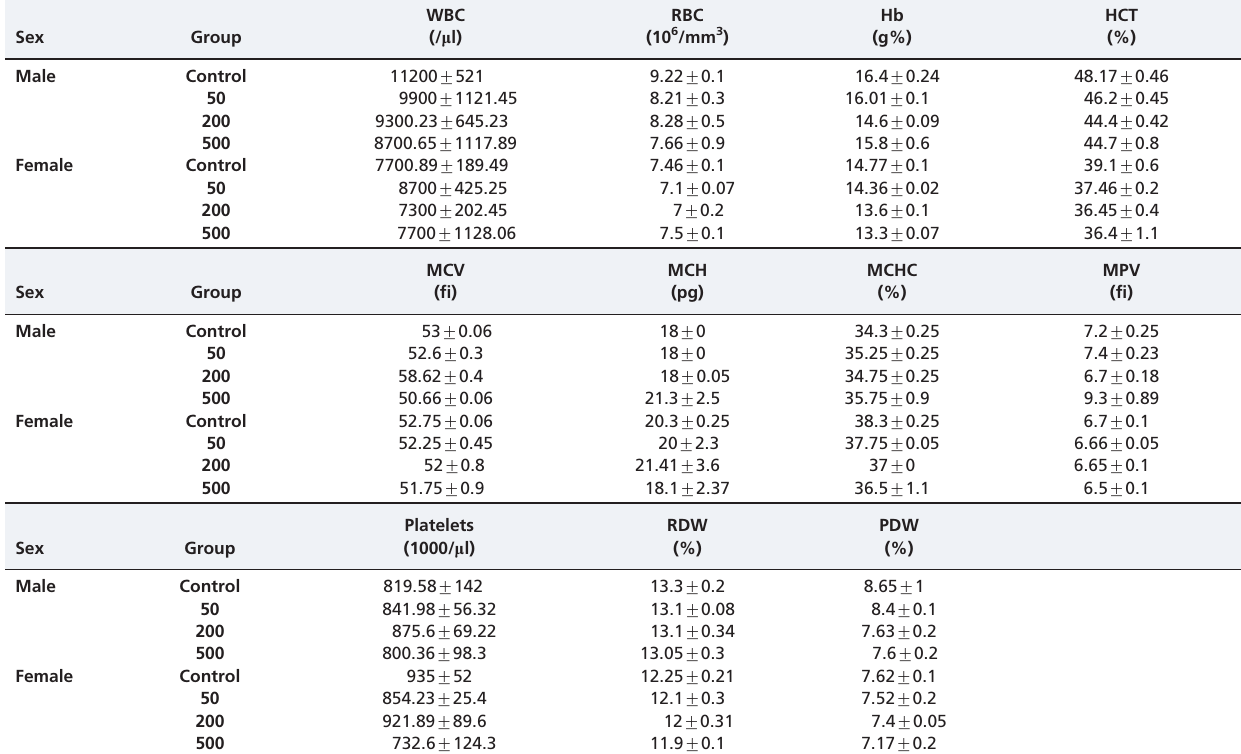
Table 1 - Hematologic parameters in Wistar rats after 45 days treatment with E. platyloba. Sex